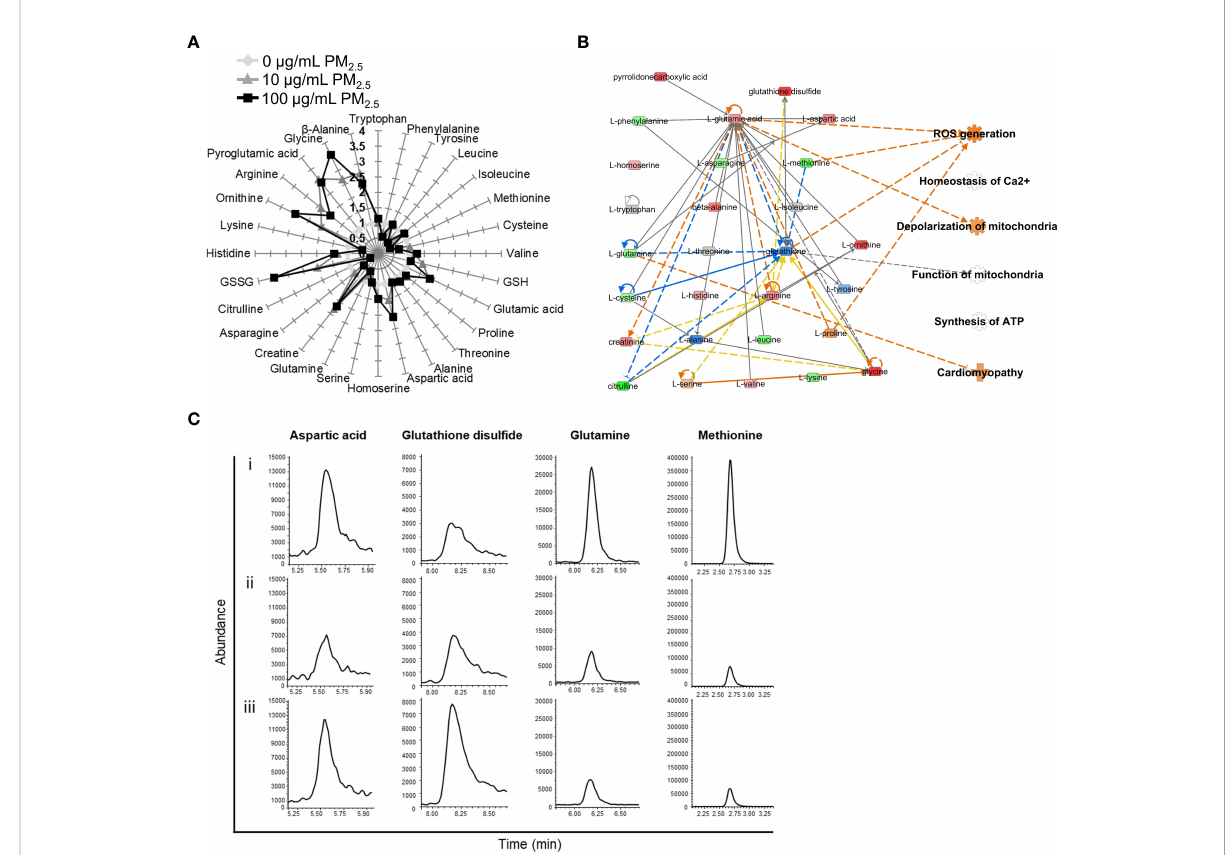
FIGURE 3 AA pro fi les of PM 2.5 -treated HL-1 cells. (A) The relative levels of 28 amino acids in 0 m g/mL PM 2.5 -treated (white), 10 m g/mL PM 2.5 -treated (gray), and 100 m g/mL PM 2.5 -treated cells (black). Each amino acid level was analyzed three times per condition. (B) The AA network with an in silico prediction of 100 m g/mL PM 2.5 -treated cells. The network was generated using IPA. Green and red indicate downregulated and upregulated amino acids, respectively. Dotted and solid lines indicate indirect and direct relationships, respectively. Details for shape and color are provided in Supplementary Figure 1 and Figure 2B. (C) SIM chromatograms of aspartic acid, glutathione disul fi de, glutamine, and methionine in (i) 0 m g/mL PM 2.5 -treated, (ii) 10 m g/mL PM 2.5 -treated, and (iii) 100 m g/mL PM 2.5 -treated